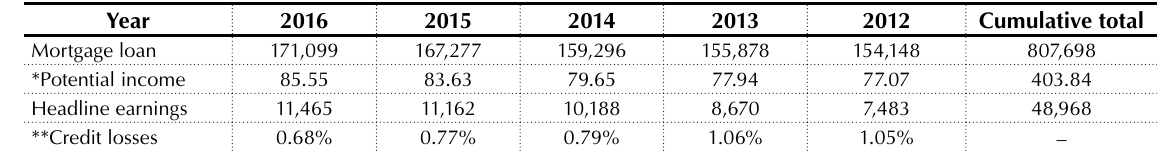
Table 1. Bank A potential BASF income as a function of mortgage loans and credit losses